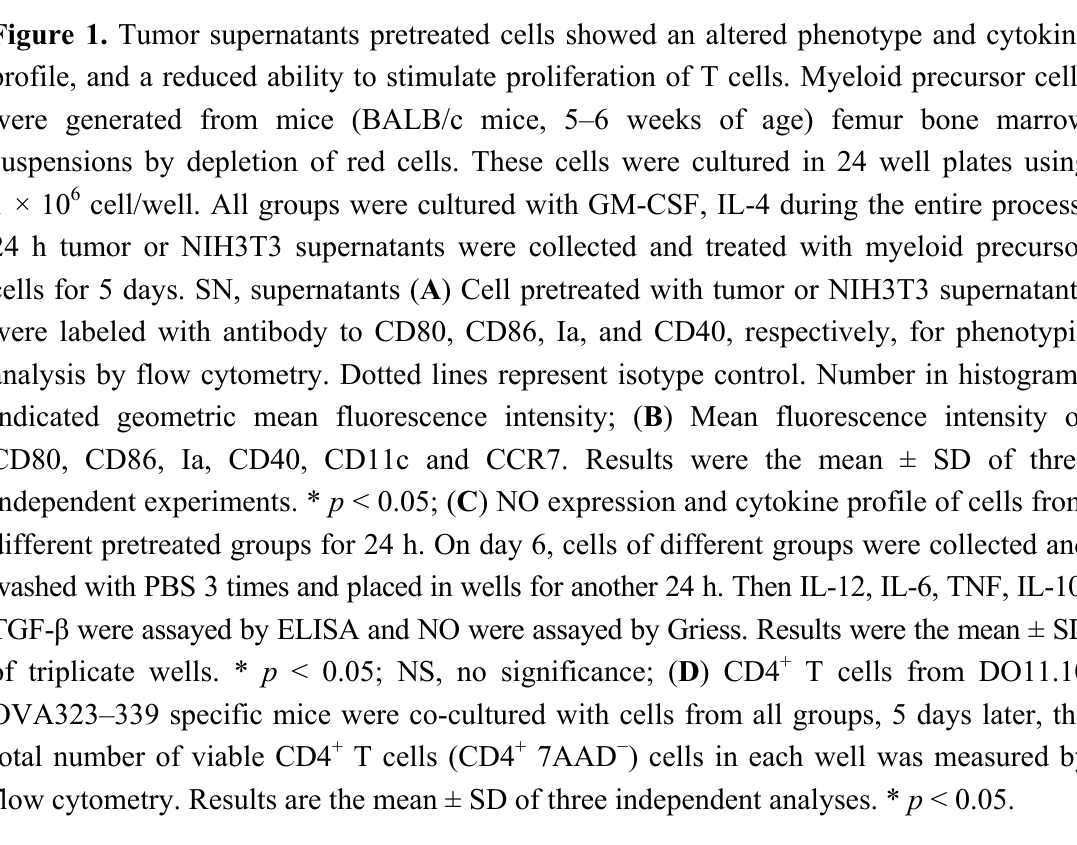
Figure 1. Tumor supernatants pretreated cells showed an altered phenotype and